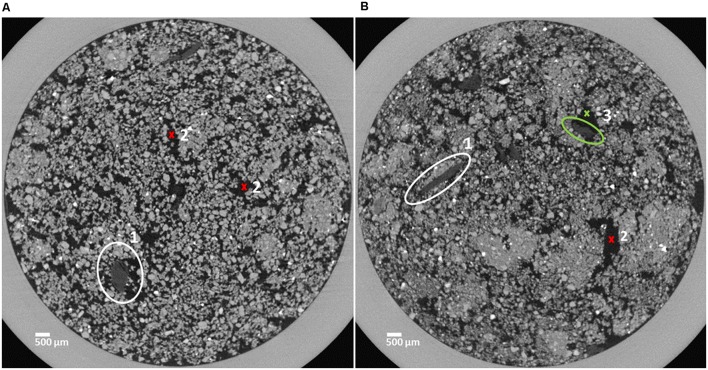
Horizontal sections of soil cores characterized by a loose structure (A) and a dense structure (B). Organic matter (OM) substrate particles are marked in the center of the white circles (1) and pore space is indicated by red crosses (2). The OM substrate particle marked by the green circle is (3) partly surrounded by pore space (green cross, 3).